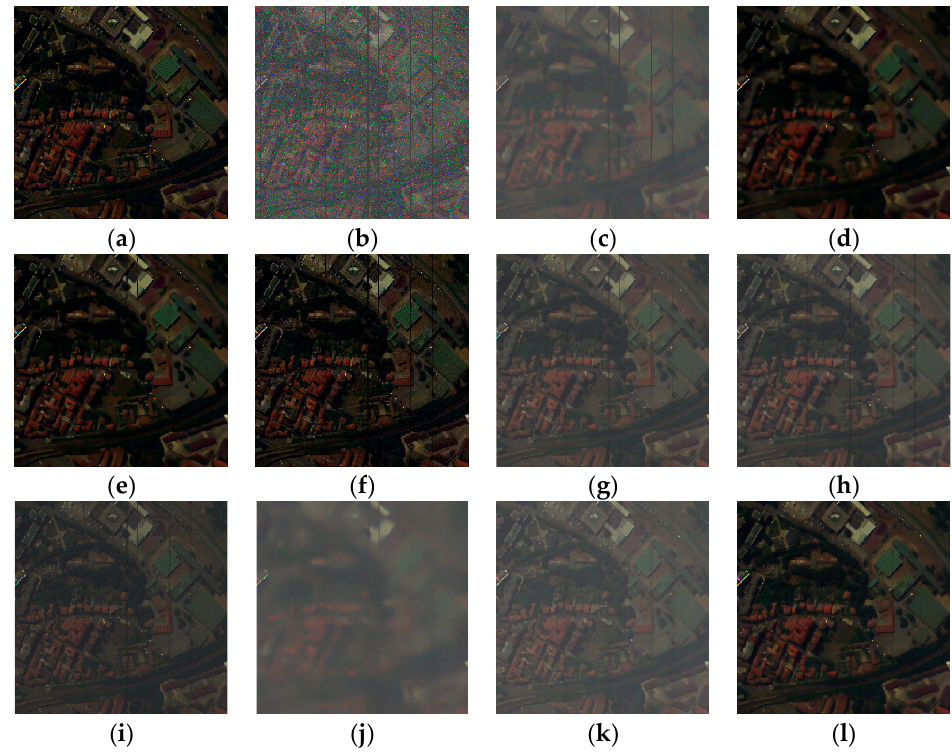
Figure 8. Restored results of the Pavia Centre data corrupted with mixed noises: ( a ) clean HSI; ( b ) noisy HSI; ( c ) BM3D; ( d ) ANLM3D; ( e ) BM4D; ( f ) LRMR; ( g ) GLF; ( h ) LRTDTV; ( i ) LTDL; ( j ) DnCNN; ( k ) HSID-CNN; ( l ) VLRMFmcl.